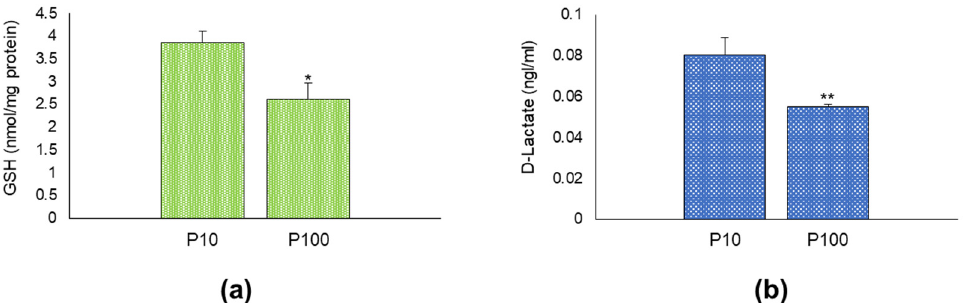
Figure 6. HASC-P10 and HASC-P100 EVs contain GSH and D-lactate. ( a ) Levels of GSH, measured by a specific GSH assay kit, as described in Materials and Methods; ( b ) levels of D-Lactate, measured by a specific D-lactate assay kit, as described in Materials and Methods. The histograms indicate the mean ± SD of two independent experiments. * p < 0.05 and ** p < 0.01 vs. P10.